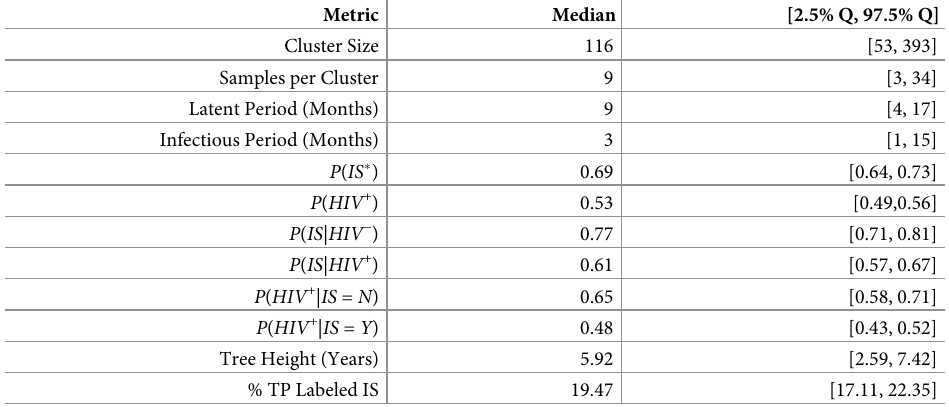
Table 1. Simulation summary statistics for 8 year simulation. Summary statistics of simulated infectious disease out- breaks from 100 simulations where probability of transmission given contact for hosts without HIV was 1.75 times larger than for hosts with HIV. � Infection Source—transmitting an infection to at least one other